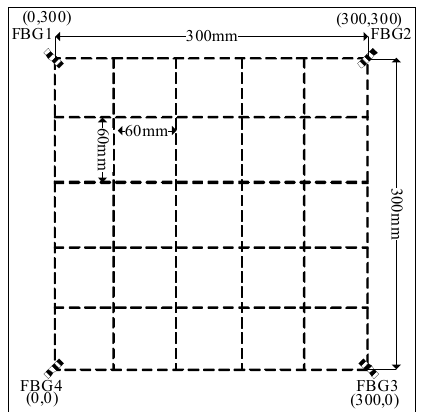
Fig. 3 Experiment layout of CFRP.